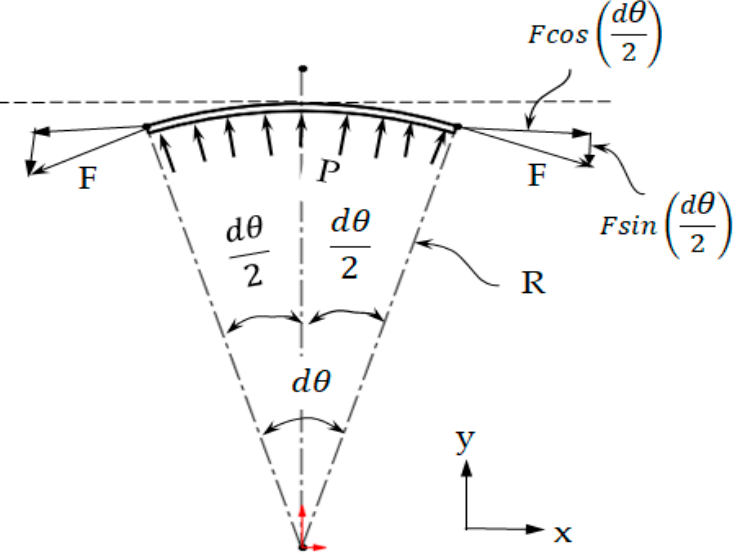
Figure 7. Differential circumference of fabric on the cylinder.